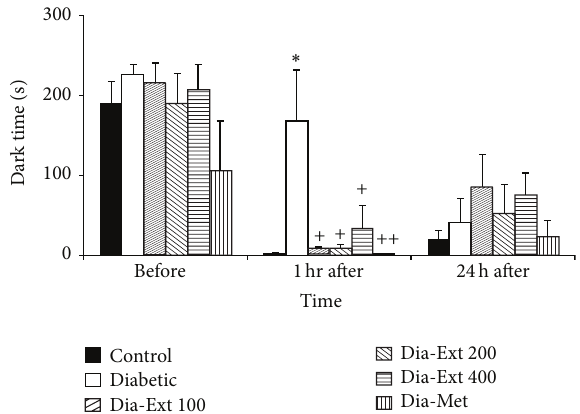
compartment by the animals of Dia-Met group was lower than that of the Diabetic group (Figure 2, 𝑃 < 0.01